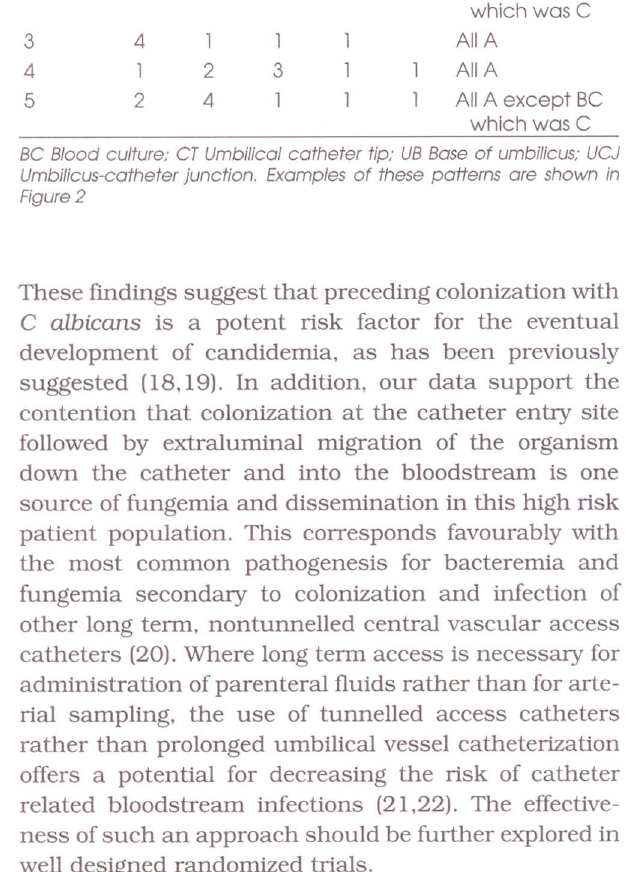
Patterns obtained after EcoRl digestion of Candida albi cans from various sites over time from neonatal intensive care patients who developed